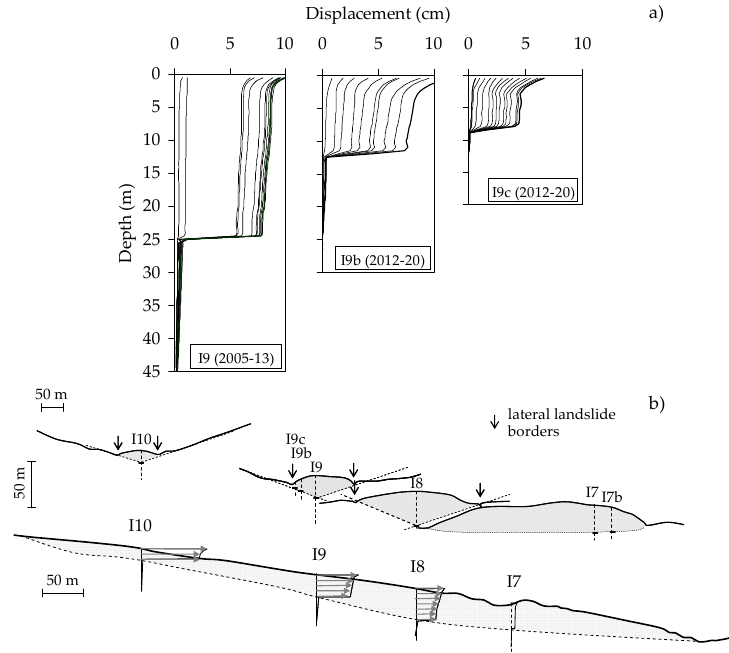
Figure 4. Costa della Gaveta earthflow: inclinometer profiles I9, I9b, and I9c (a) ; longitudinal section with inclinometer profiles relative to the same time period and transversal sections (b) .